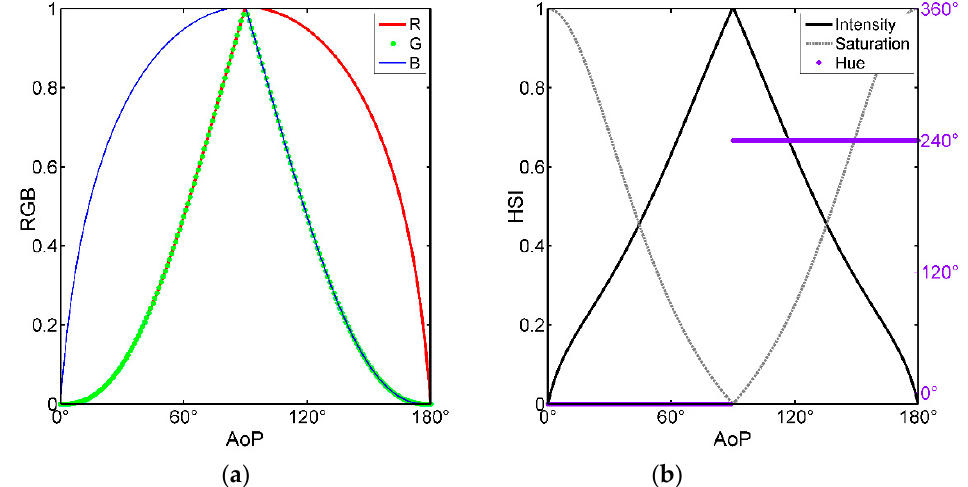
Figure 3. ( a ) The variation of RGB value with AoP in our method; ( b ) The variation of HSI value with AoP in our method.